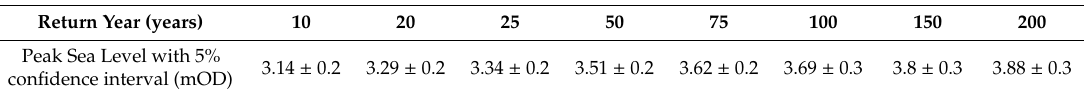
Table 2. The Skew Surge Joint Probability Method (SSJPM) results at Felixstowe (values are from [51], adapted with permission from Environment Agency under Open Government License